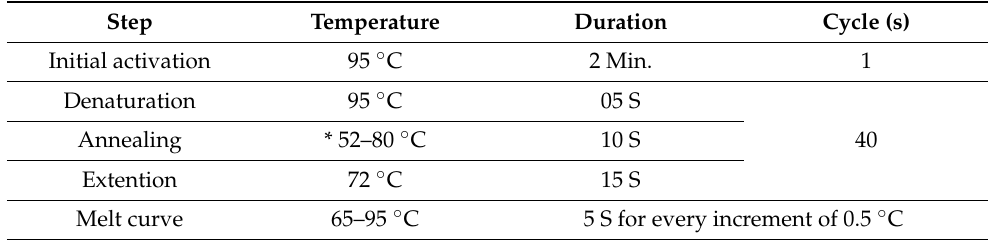
Table 5. Cycling parameters for